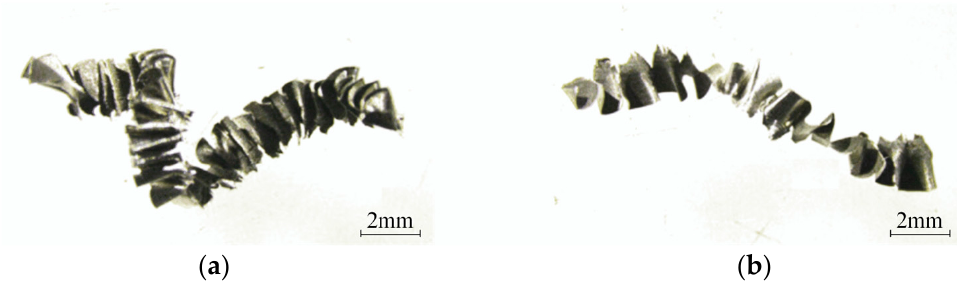
Figure 7. Chip morphology of DD and UVD. ( a ) DD; ( b ) UVD. ( n = 1200 r/min, f r = 0.01 mm/min, f =